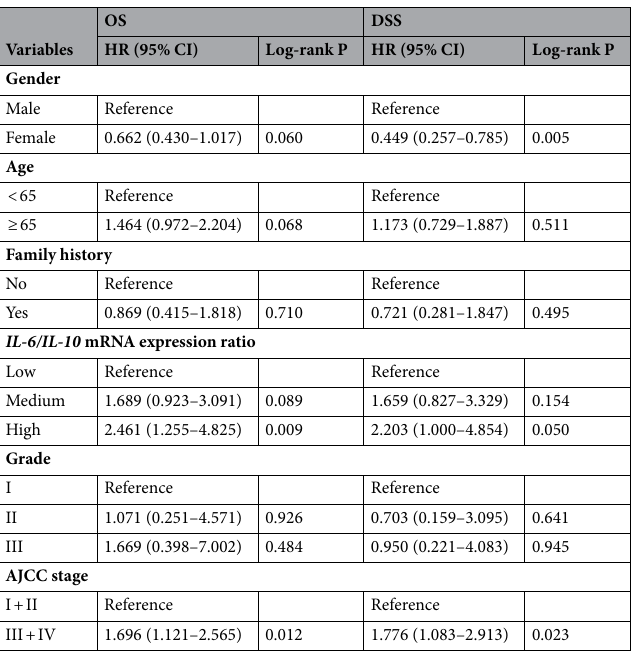
Table 4. Multivariate Analysis for OS and DSS of STAD Patients without Distant